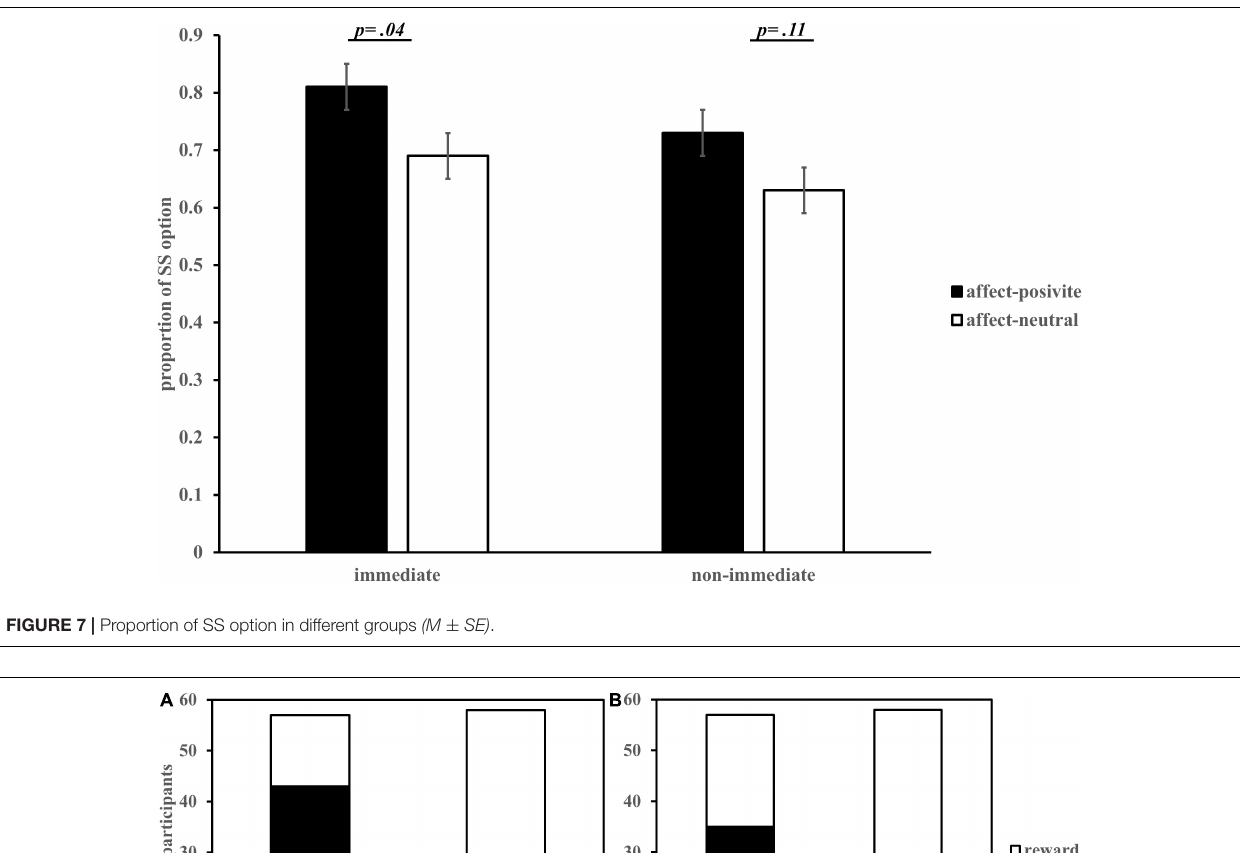
FIGURE 8 | Attributes that participants pay attention to in attributes attention test: (A) attribute of first attention, (B) attribute of most